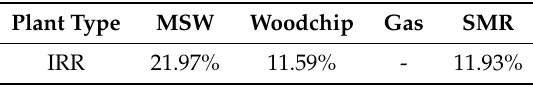
Figure 11. The LCOE breakdown ( a ) and the NPV and IRR ( b ) of the additional CHP investments considered with wind power values for reference. Table 6. The total IRRs for CHP